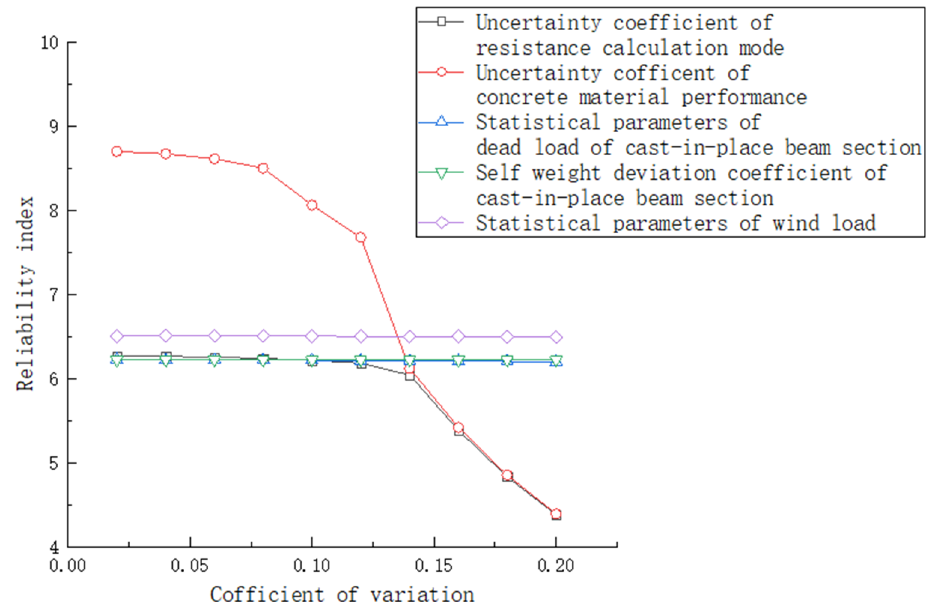
Figure 7. Effect of coefficient of variation of each parameter on strength reliability index under combination II.